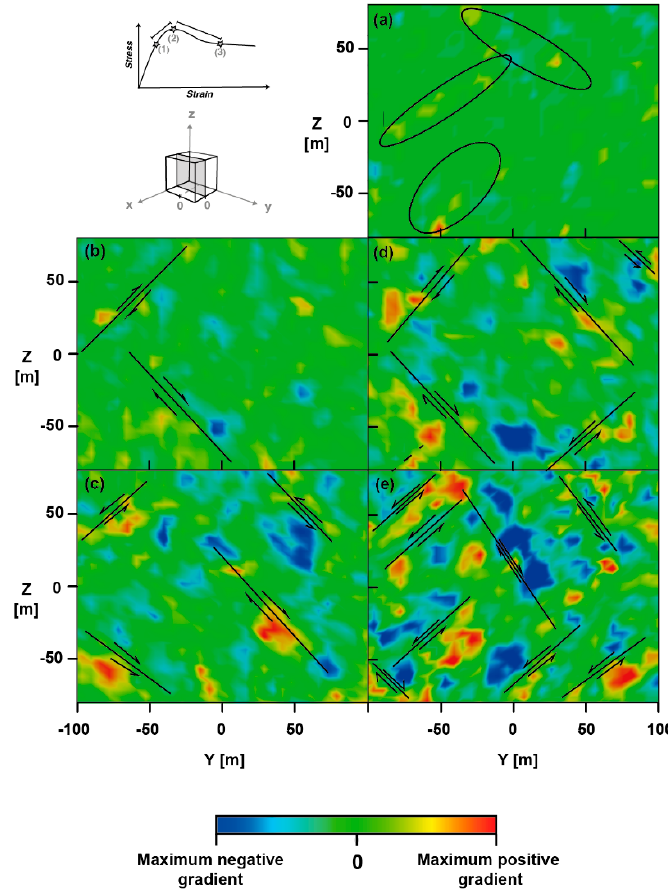
Figure 5. Strain localization visualized for deformation stages. Deformation stages are defined between points (1) and (3) along a typical stress–strain curve, where (1) is the yield stress, (2) the peak stress and (3) the post-peak situation. Deformation is imaged along a vertical cross section of the 3D test (location indicated by the grey cross section). ( a ) Initiation of strain localization highlighted by oval circles (between stages 1 and 2, Experiment DC-2). Localization is presented for four samples tested under confining stress σ 2,3 = 250 kPa. ( b ) Experiment LS-2, loose ’sand’ ( G p = 1e 10 Pa) taken after 17% of strain ( c ) Experiment DS-2, dense ’sand’ ( G p = 1e 10 Pa) taken after 17% of strain. ( d ) Experiment LC-2, loose ’clay’ ( PB coh = 110e 3 Pa) taken after 12% of strain. ( e ) Experiment DC-2, dense ’clay’ ( PB coh = 110e 3 Pa) taken after 12% of strain. Black lines indicate selected areas of strain localization further explained in the text.